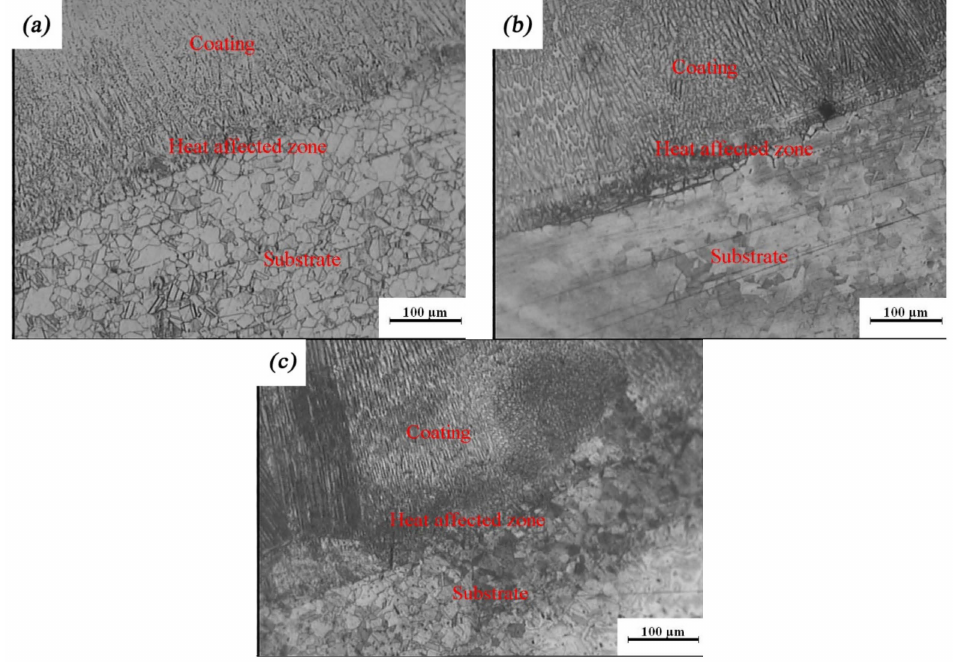
Figure 3. Optical images of rare earth oxide-modified 316L cladding layer: ( a ) no addition; ( b ) 2% La 2 O 3 ; ( c ) 2% CeO 2